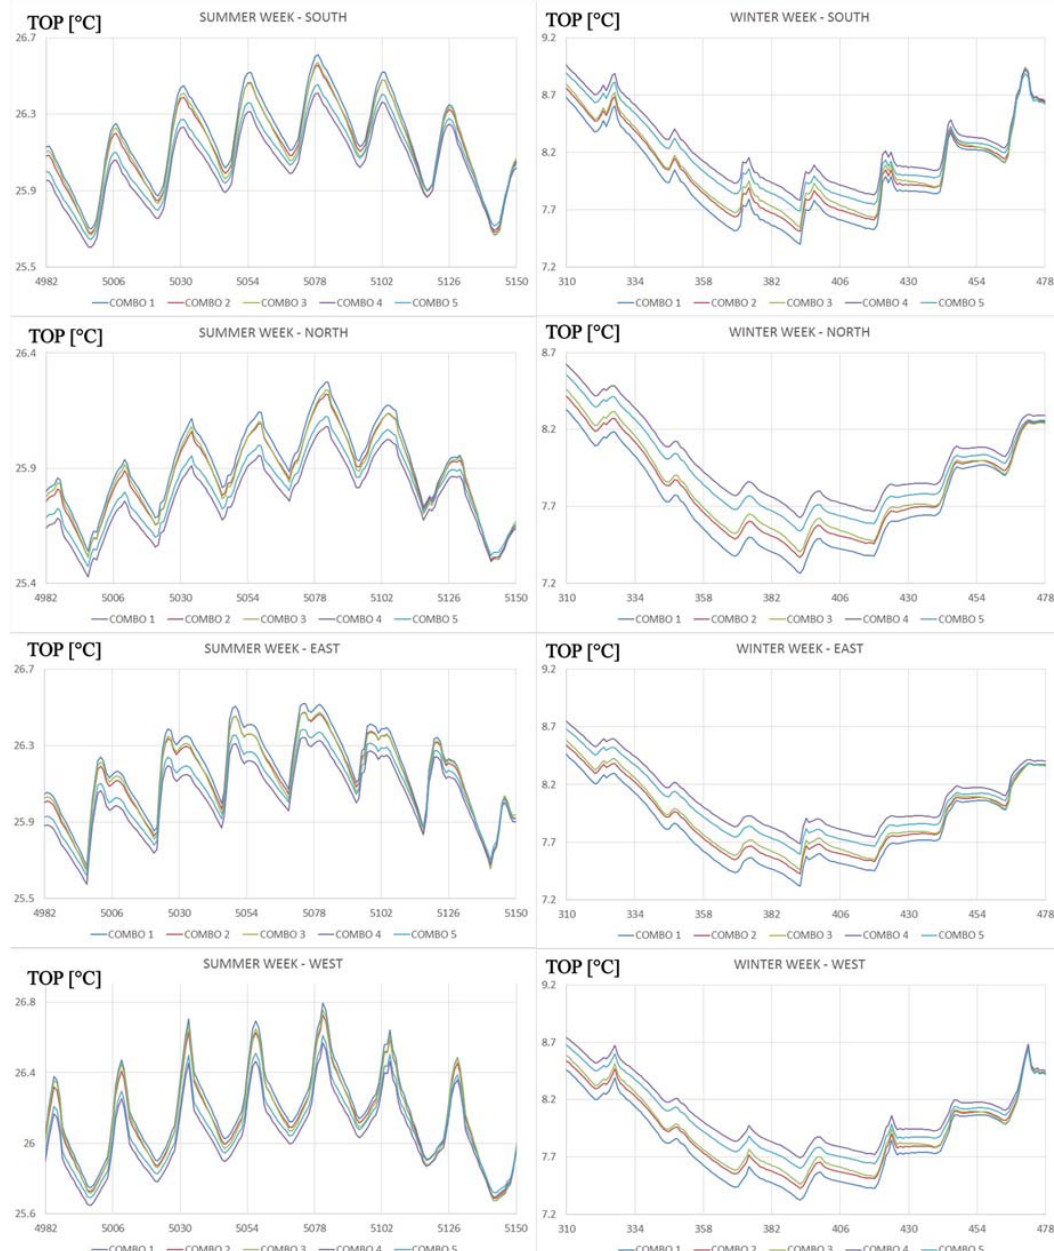
Figure 4. TOP graphical trend for the STEP 1 (27 July–2 August; 12 January–18 January).